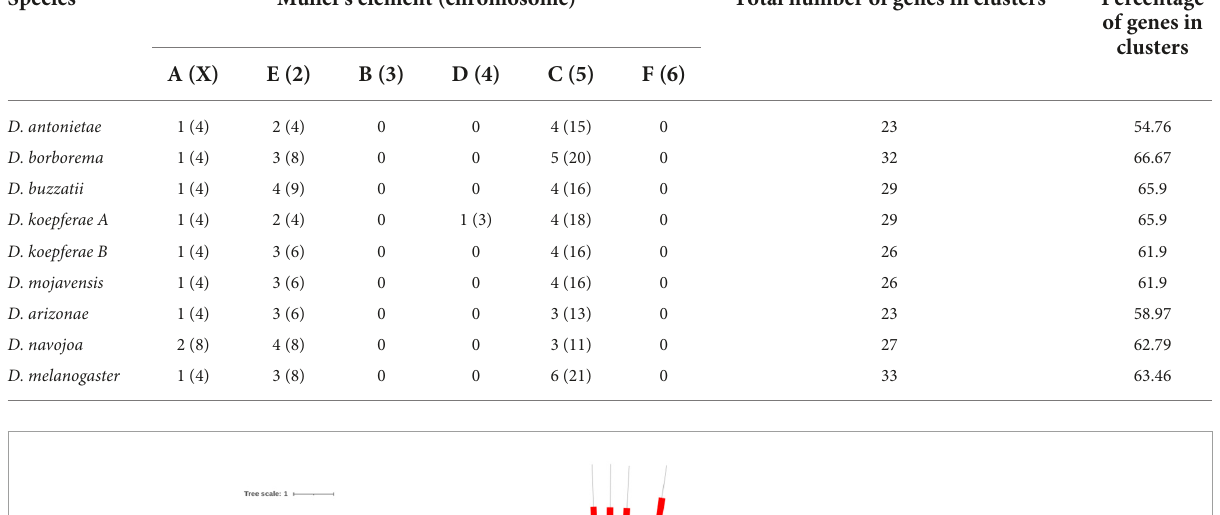
of genes in clusters